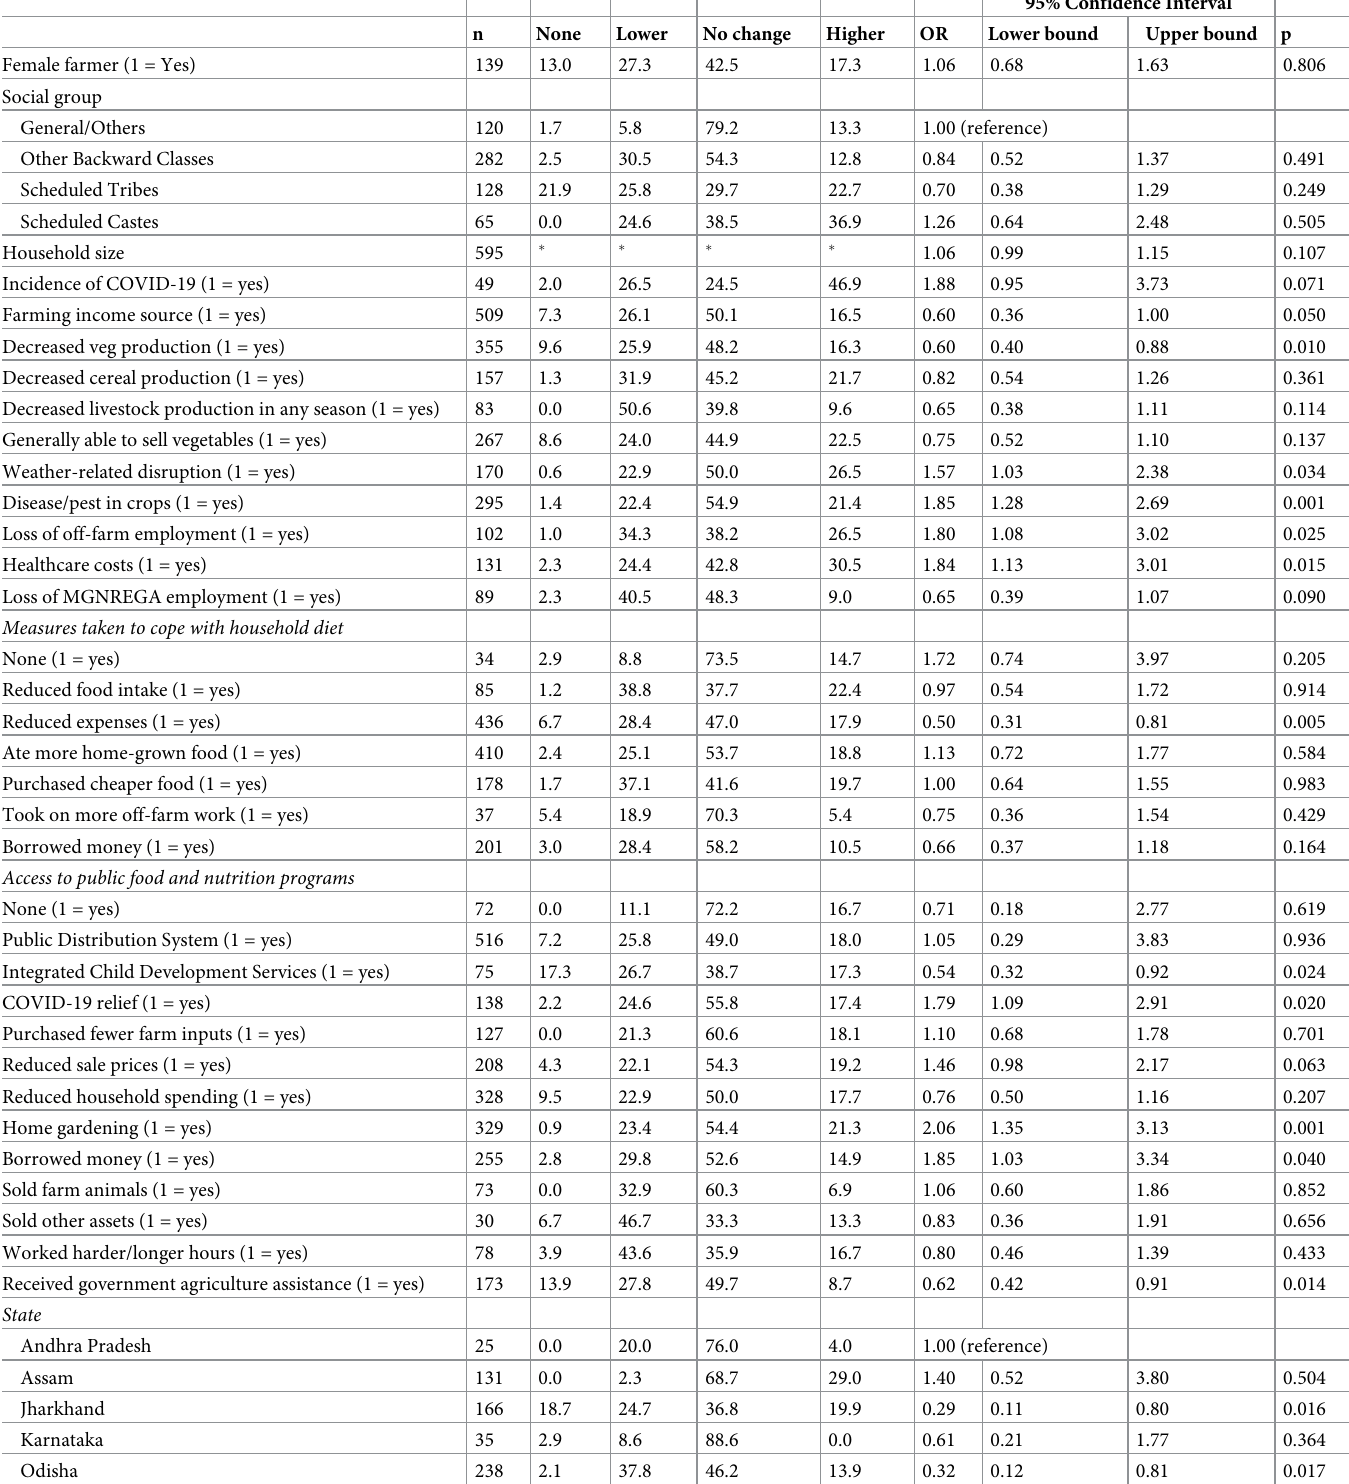
Table 4. Factors associated with vegetable consumption during